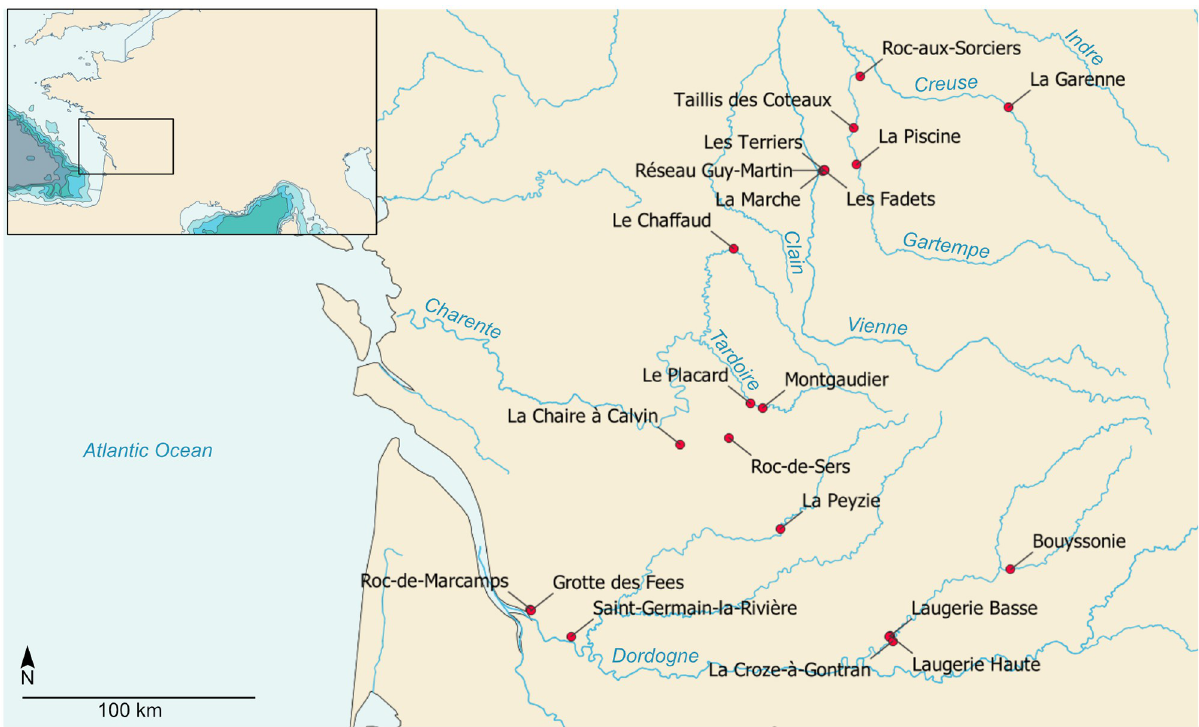
Fig 1. Early Middle Magdalenian cave or rock shelter sites of west-central France. Basemap: Natural Earth, QGis software.